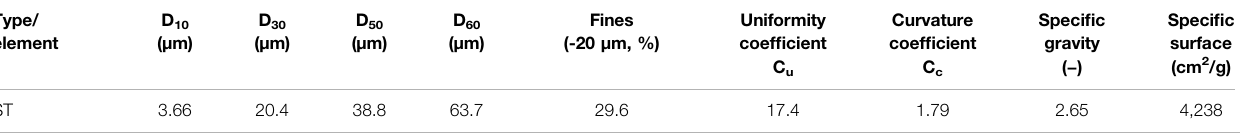
TABLE 1 | A summary of physical characteristics of the studied ST material. Type/